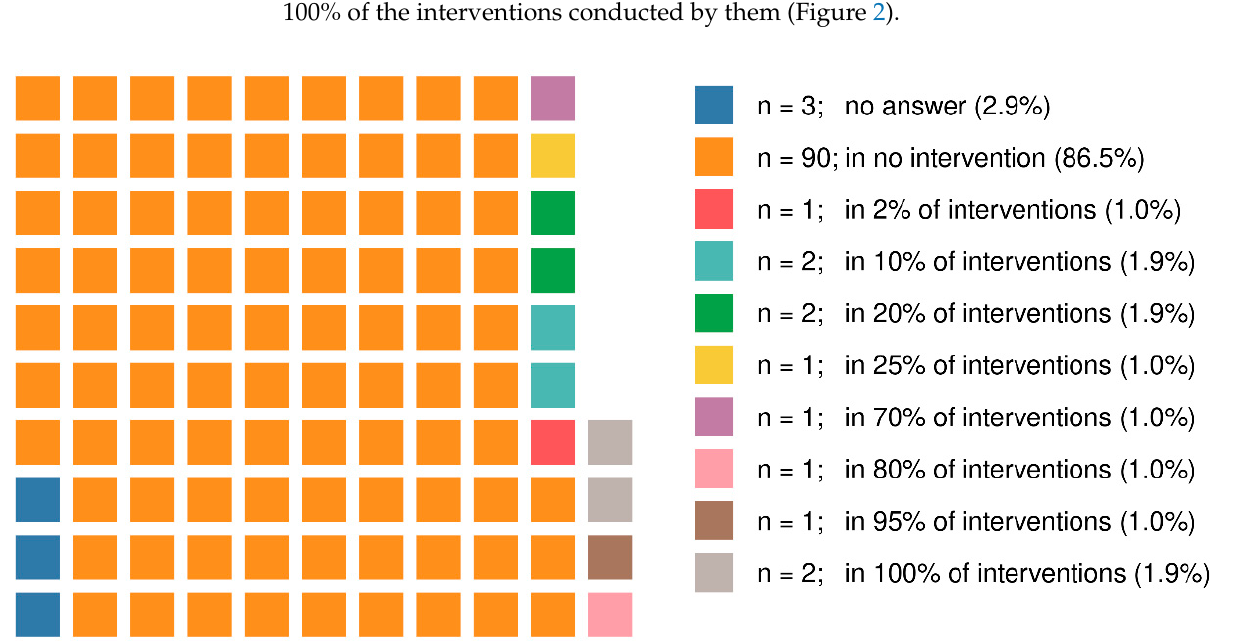
Table 3. Information on the availability and use of interventional installations.